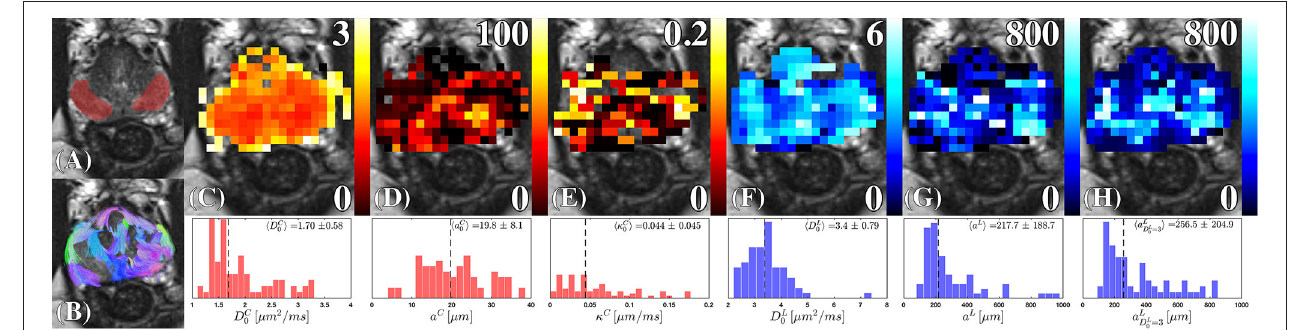
FIGURE 9 | Cellular and luminal parameters derived from D ( t ). (A) The peripheral zone ROI, is overlaid onto a high-resolution T 2 -weighted image. (B) The probabilistic fiber tracks, derived from the cellular compartment, are color coded by their terminal endpoints. These tracks were derived from a dyadic tensor across all diffusion times. (C) Cellular diffusivity, D C 0 , (D) cellular fiber diameter, a C , and (E) cellular membrane permeability, κ C , were derived from the RPBM applied to the cellular diffusion tensor. The (F) luminal diffusivity, D L 0 , (G) luminal diameter, a L , and (H) the luminal diameter, a L diffusion tensor. The corresponding histograms under each parameter map, show the range and median (dashed line) of the modeled parameter under the ROI (A) combining estimates obtained from all